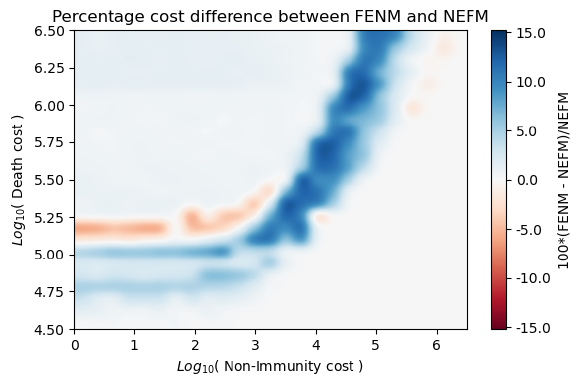
Figure 8. Heatmap showing percentage difference in total cost between final solutions obtained by FENM and NEFM, as a function of death and non-immunity cost.